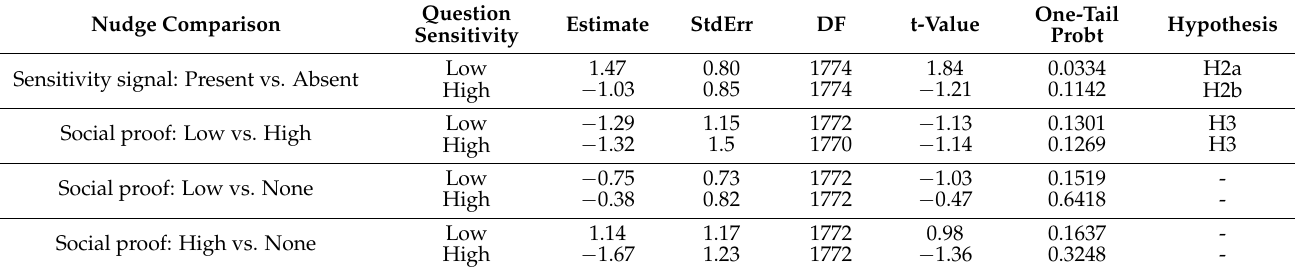
Table 9. Logistic Regressions: Effect of Nudges on Response Rate Per Question